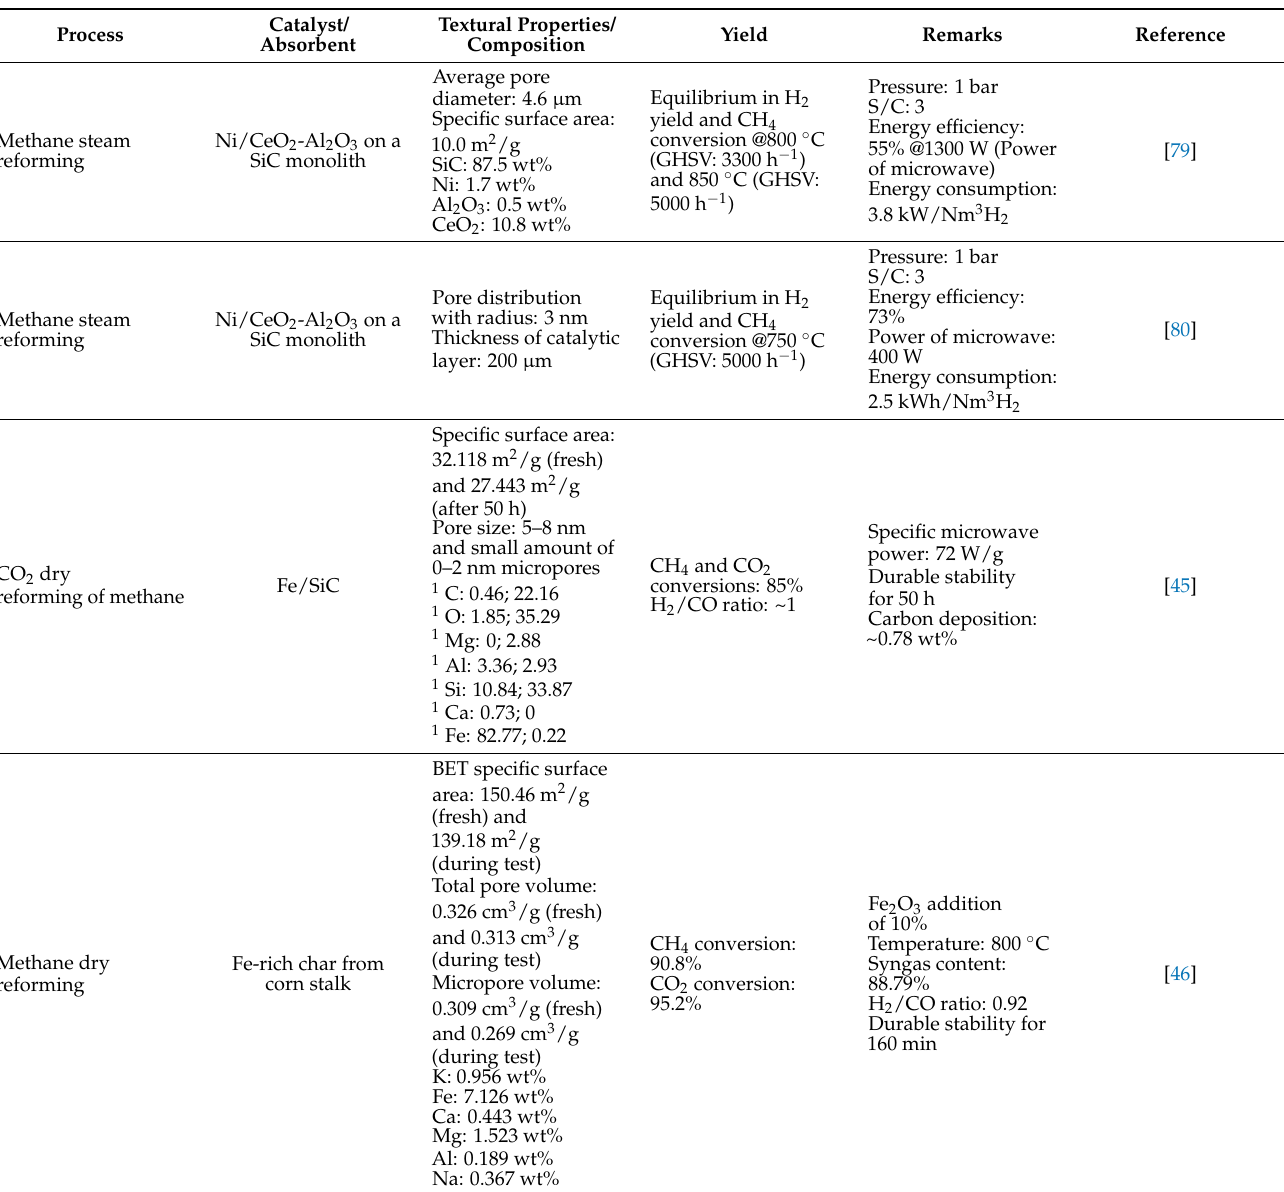
Table 7. Methane reforming using microwave-assisted